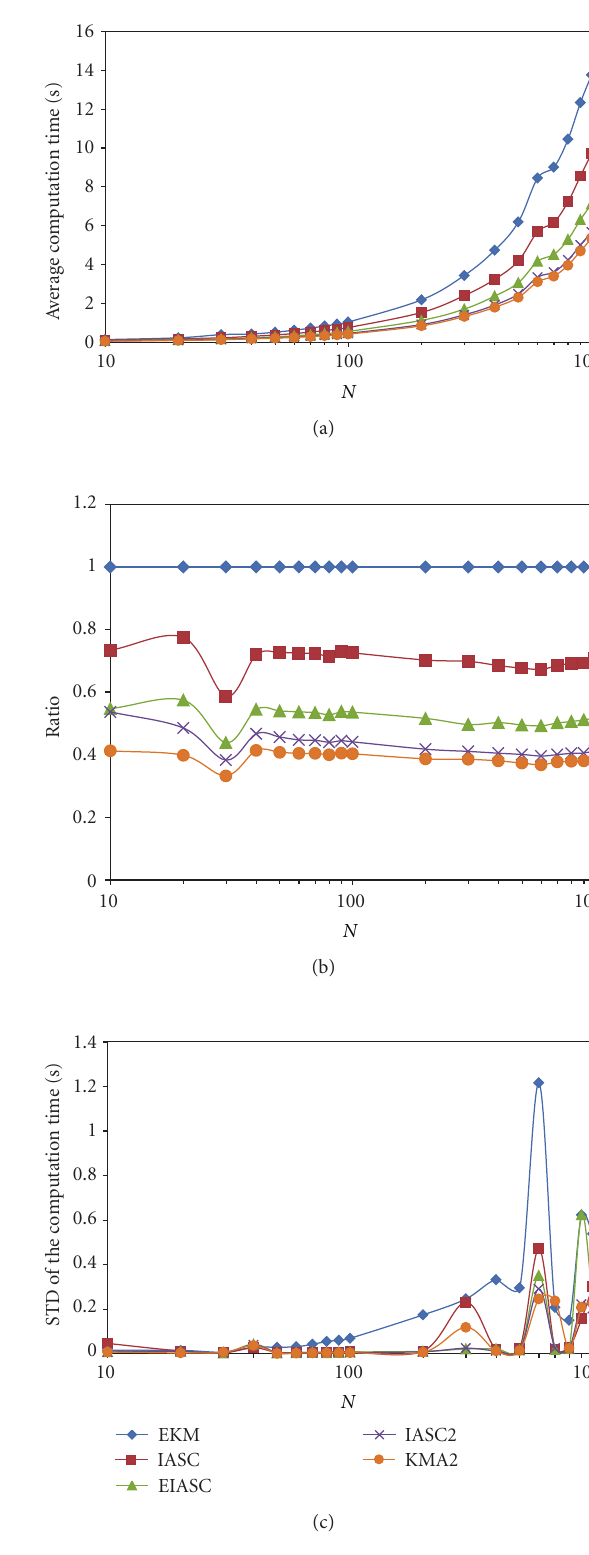
Figure 11: Uniform random FOU results (interpreted language implementation of the algorithms). (a) Average computation time, (b) ratio with respect to the EKMA, and (c) standard deviation of computation time.